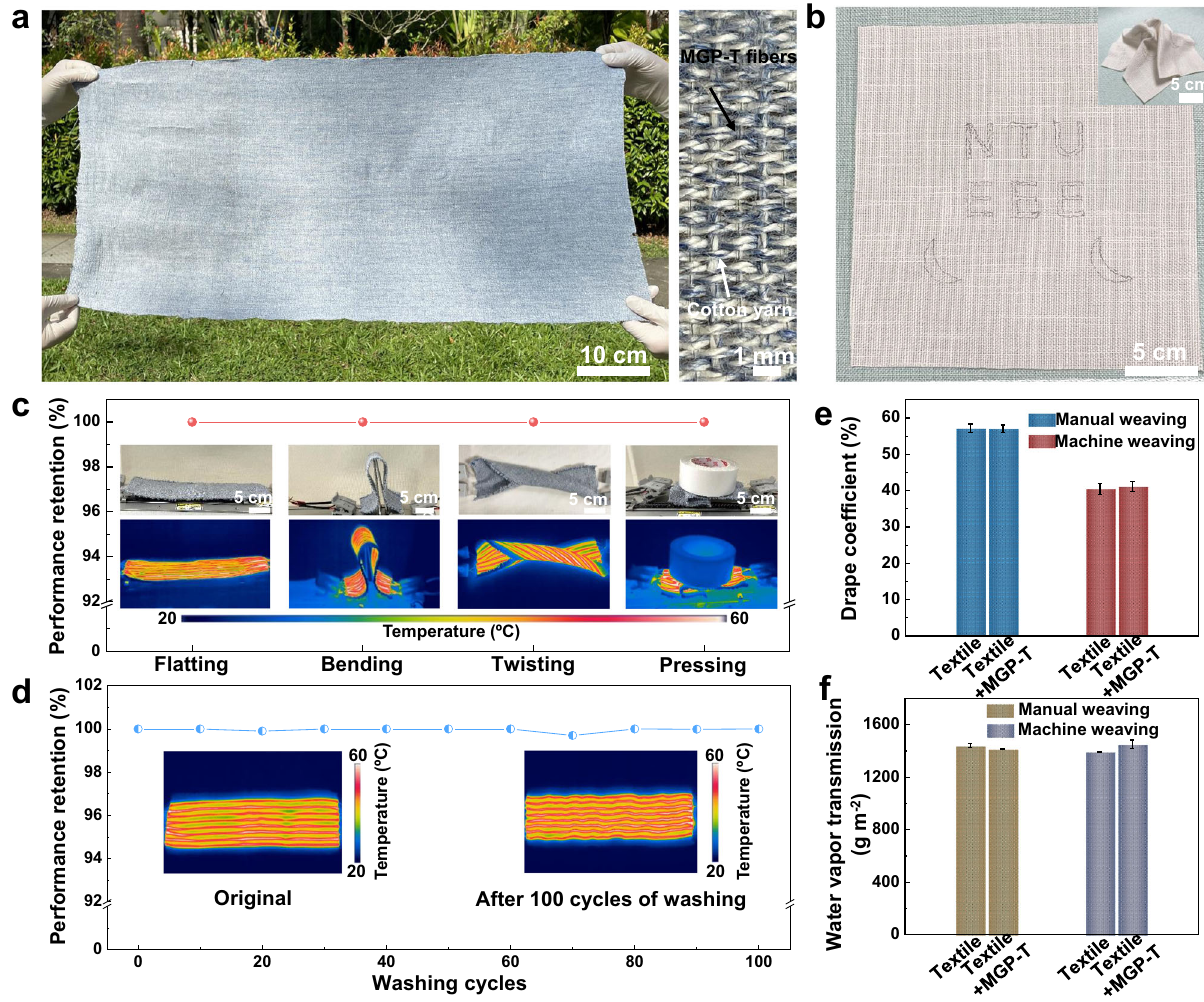
Fig. 7 | Large-scale wearable MXene textiles. a Photograph of a textile (0.8 m by 0.4 m) prepared via machine weaving with MGP-T fi bers. b Designed patterns woven into the cotton cloth under complex deformations (inset). c Deformation stability of the machine weaving textile. d Washing durability for atextile after 100